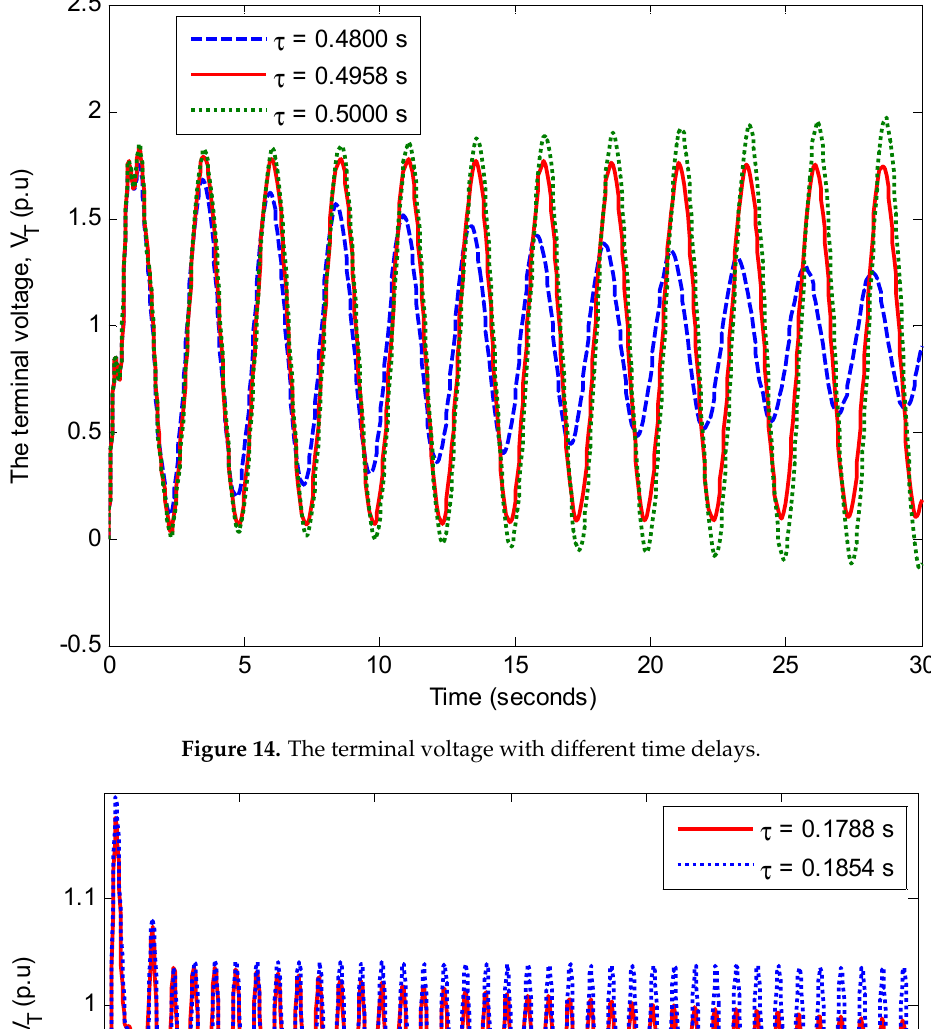
Figure 13. The terminal voltage with different time delays.